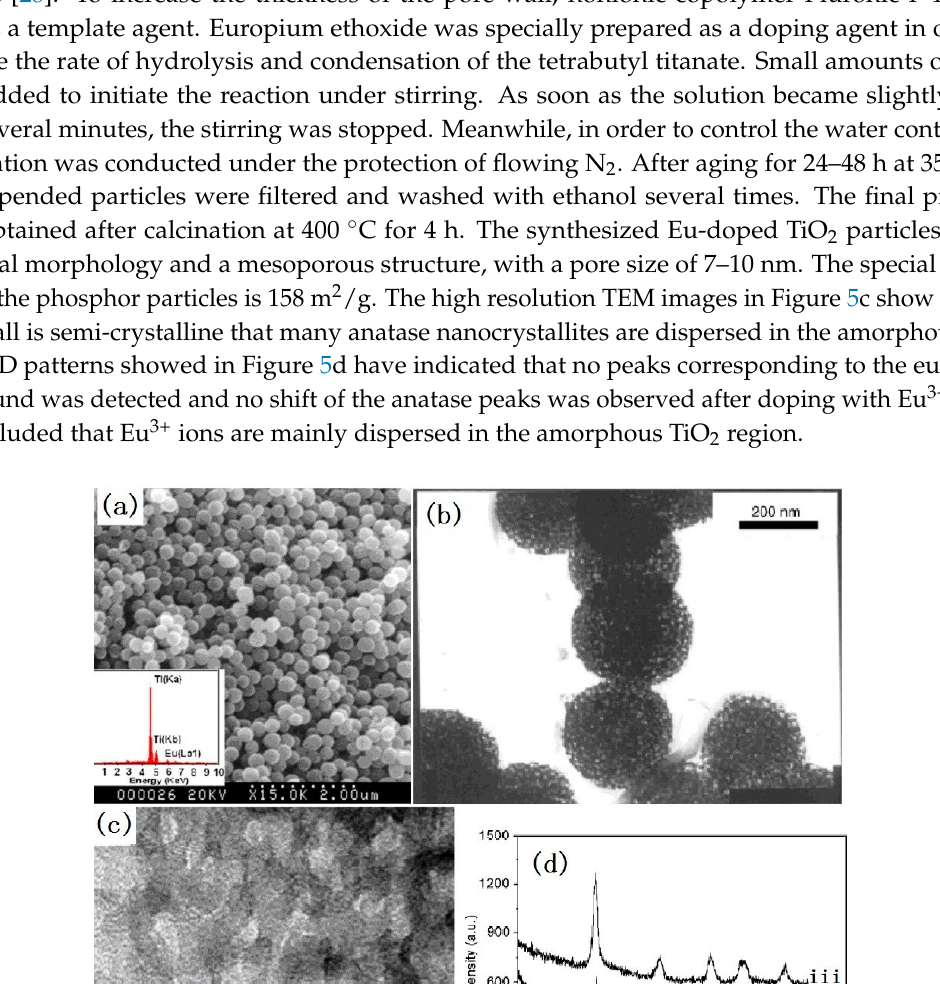
Figure 5. ( a ) SEM image and EDS spectra, ( b ) TEM image, ( c ) high resolution TEM image and corresponding electron diffraction pattern of monodisperse mesoporous after 400 °C calcinations, ( d ) XRD patterns: (i) before calcinations, (ii) after 400 °C calcinations, and (iii) after 500 °C calcinations [28].